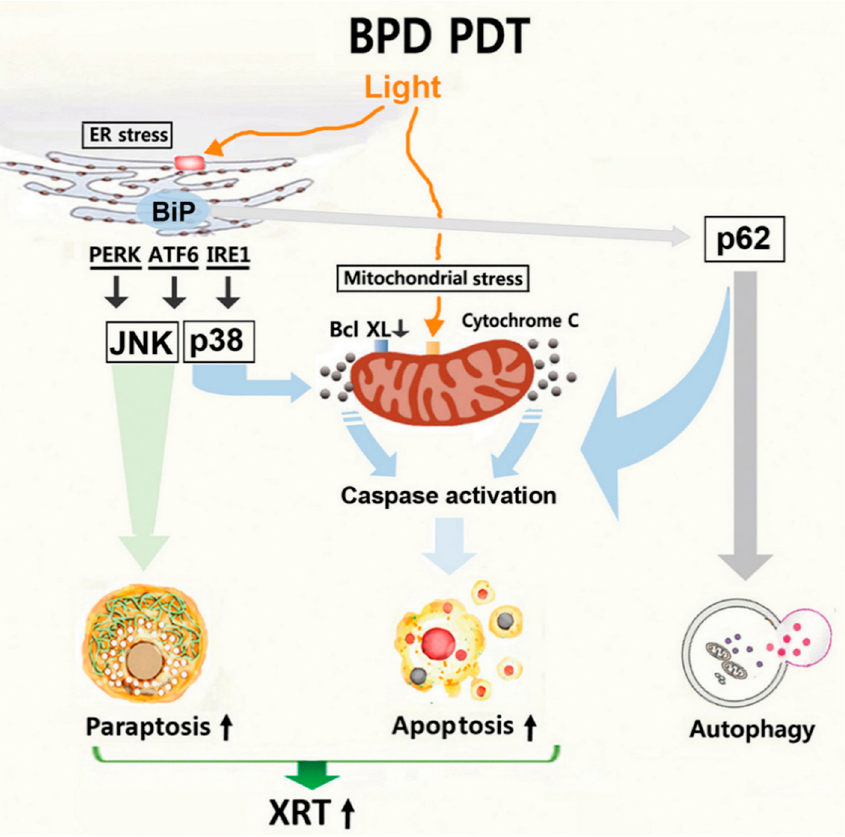
Figure 5. A working model of BPD-PDT-mediated paraptosis, apoptosis and sensitization to XRT.